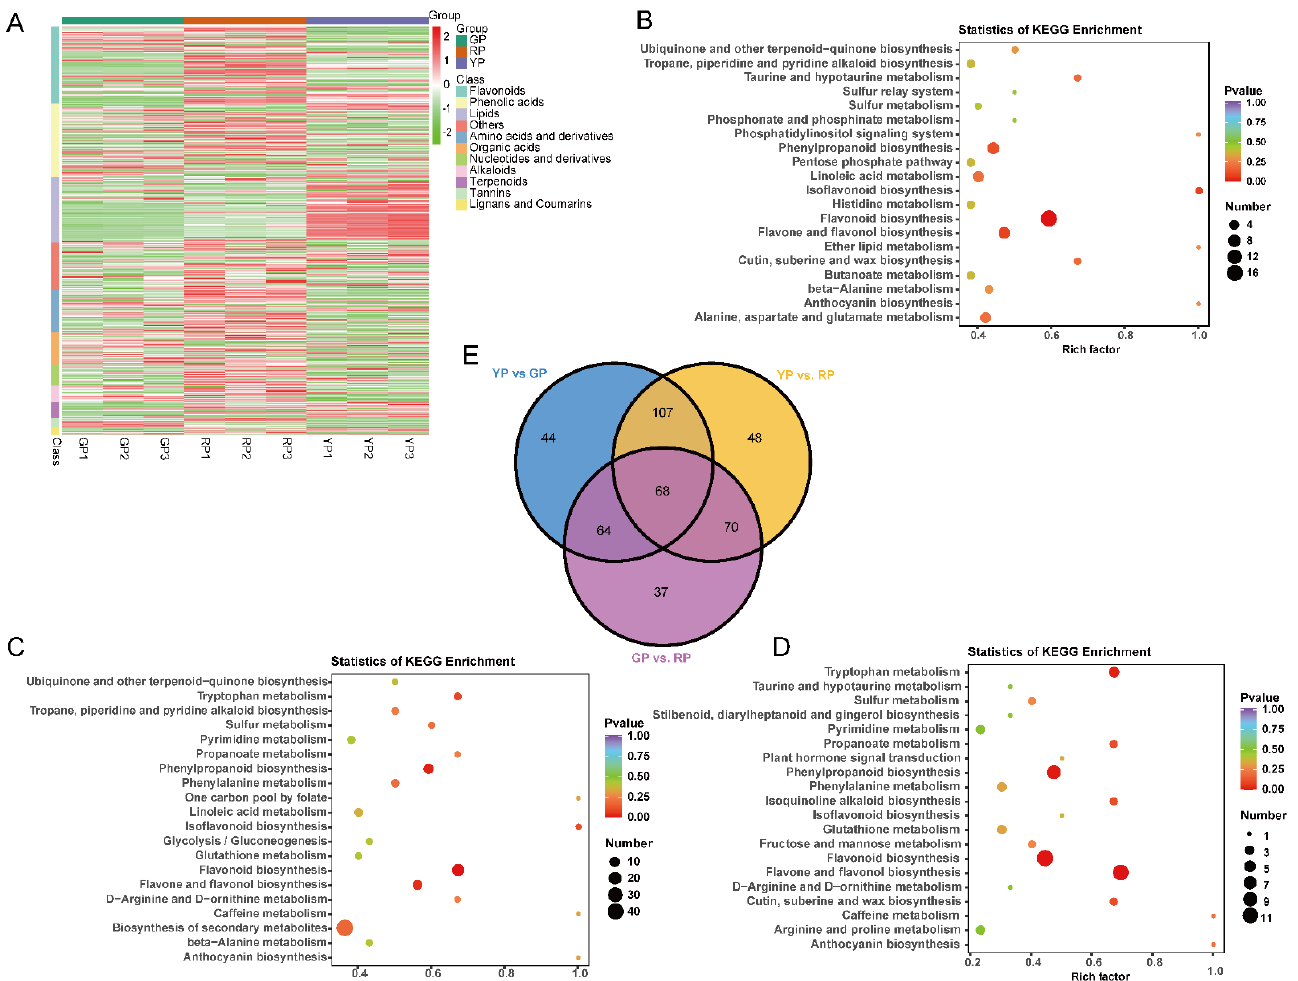
Figure 3. DAM identification: ( A ) heat map of DAM classification and KEGG enrichment scatter plots: ( B ) YP vs. GP; ( C ) YP vs. RP; ( D ) GP vs. RP; ( E ) Venn of DAMs among the three variations.